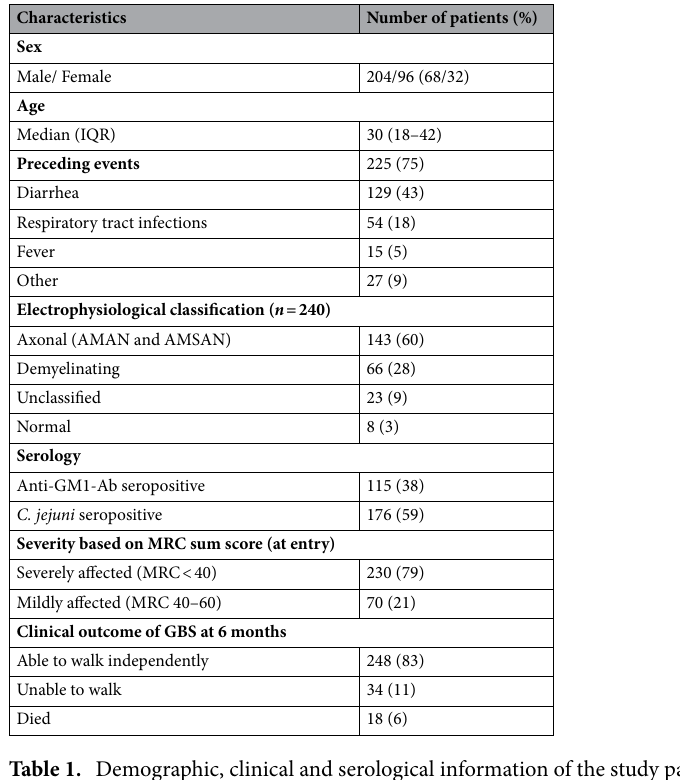
Table 1. Demographic, clinical and serological information of the study patients ( n = 300). IQR interquartile range, Ab antibody, C. jejuni Campylobacter